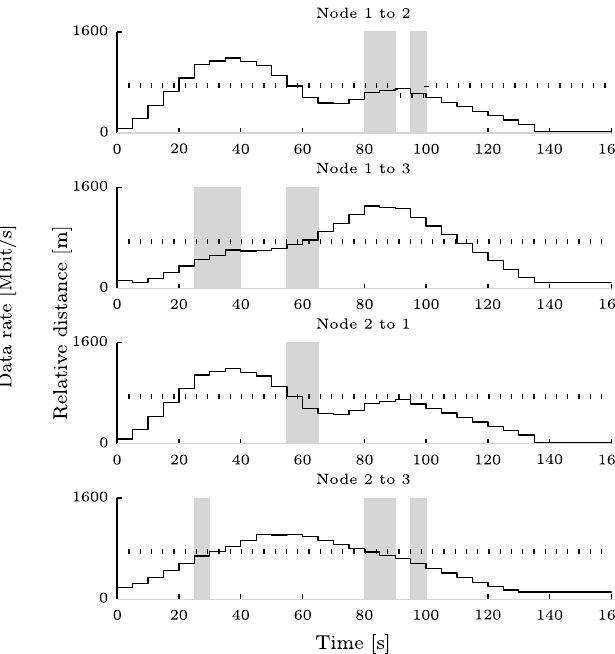
Figure 16: Scenario 2: The relative distance between nodes (solid black), and the MILP rela- tive distance constraint for communication (dashed black) at the 3rd and final iteration. See also caption text for Figure